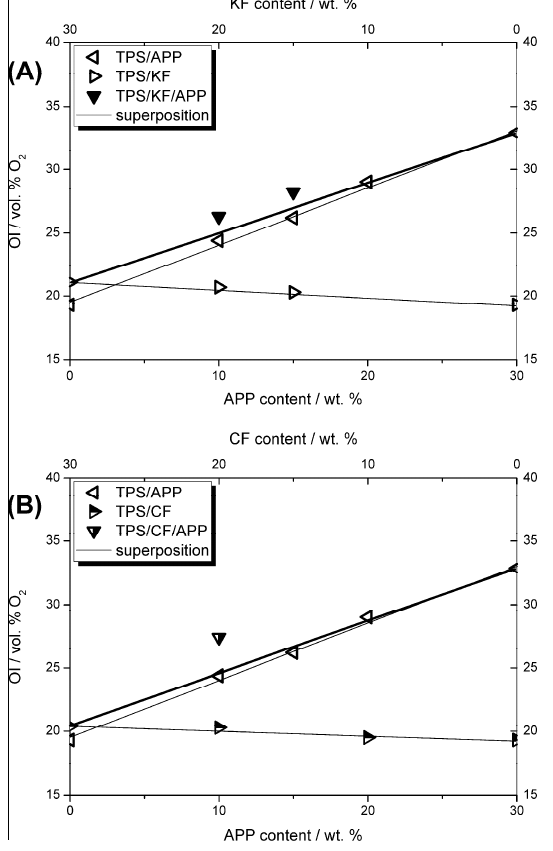
Figure 10. Content dependency and synergy of oxygen index for KF ( A ) and CF ( B ) formulations. Thin lines represent the linear behaviour of the OI for the single components derived from OI measurements of TPS/APP (hollow triangles pointing left), TPS/KF (hollow triangles pointing right) and TPS/CF (half-filled triangles pointing right) formulations, the thick line represents the calculated superposition of the fibre/APP combinations. The OI measured for fibre/APP combinations in TPS are displayed as solid triangles pointing down (TPS/KF/APP) and half-filled triangles pointing down (TPS/CF/APP).